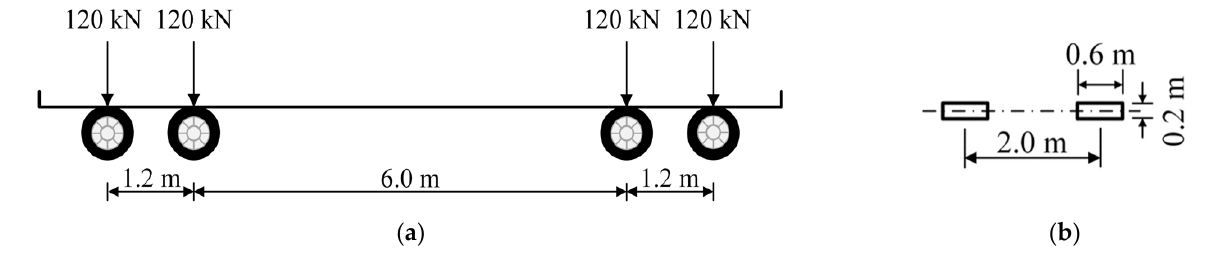
Figure 4. Fatigue load model: ( a ) Axle arrangement; ( b ) Standard axle.